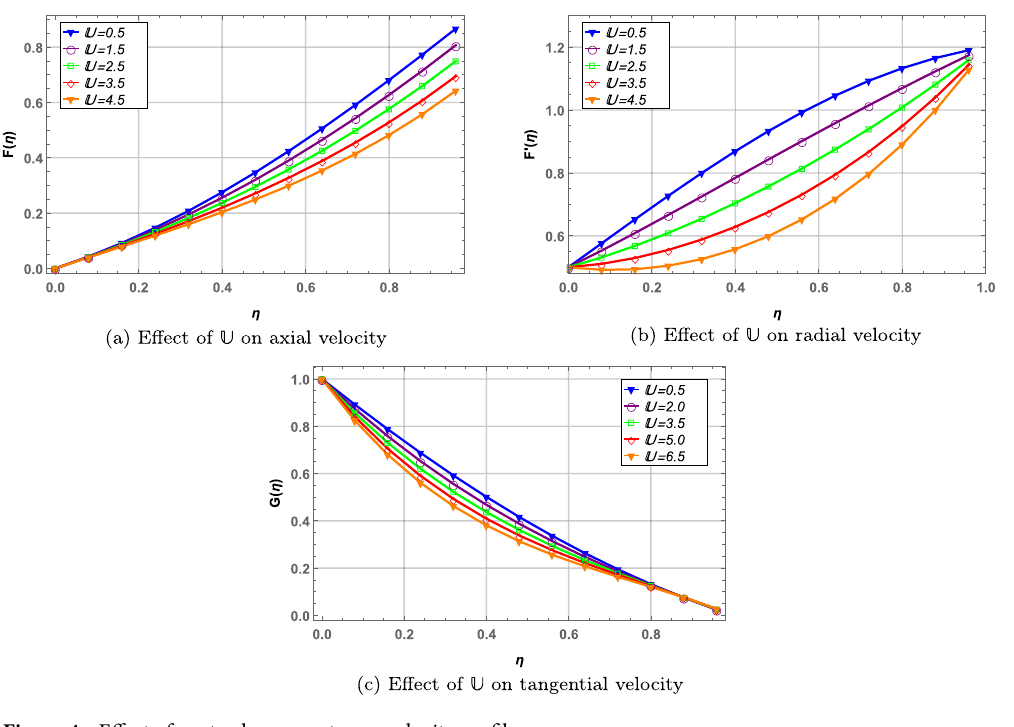
Figure 4. Effect of unsteady parameter on velocity profile.